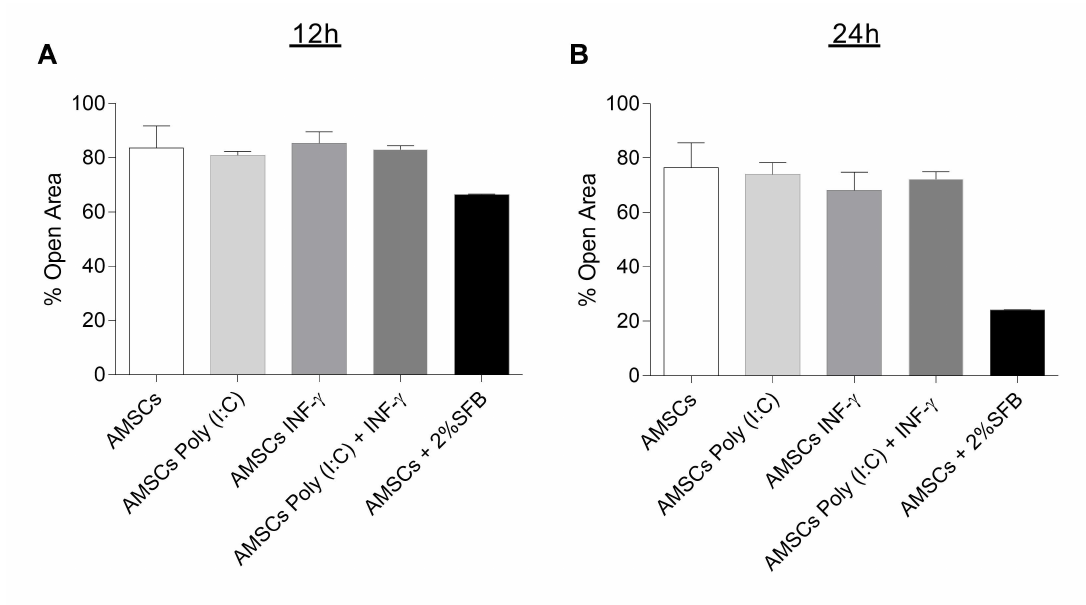
Figure 2. Migratory potential of licensed and unlicensed AMSCs. ( A ) Wound scratch assays for unlicensed AMSCs, as well as licensed AMSCs treated with either 1 µ g/mL Poly (I:C), 50 ng/mL INF- γ or with both 50 ng/mL of INF- γ and 1 µ g/mL of Poly (I:C). Confluent cells were wounded by a scratch with a pipette tip and cell migration was assessed under the microscope at 12 h and 24 h ( B ). Results are presented as mean ± SEM of three independent